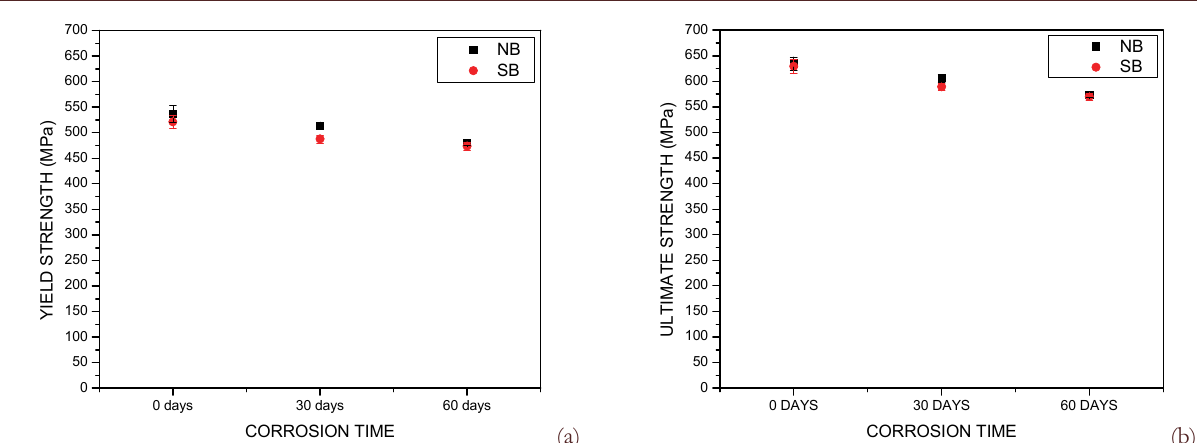
Figure 13: Yield strength (a) and ultimate strength (b) of as-received as well as sandblasted specimen at each corrosion exposure period.